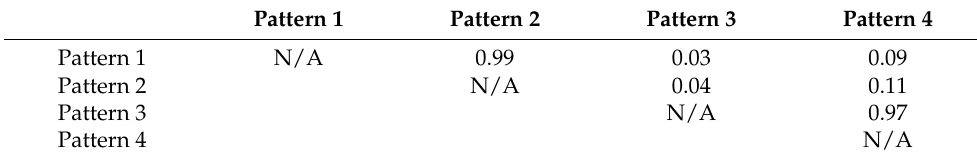
Table 4. p -value of the Tukey post hoc test between the two MAEs.